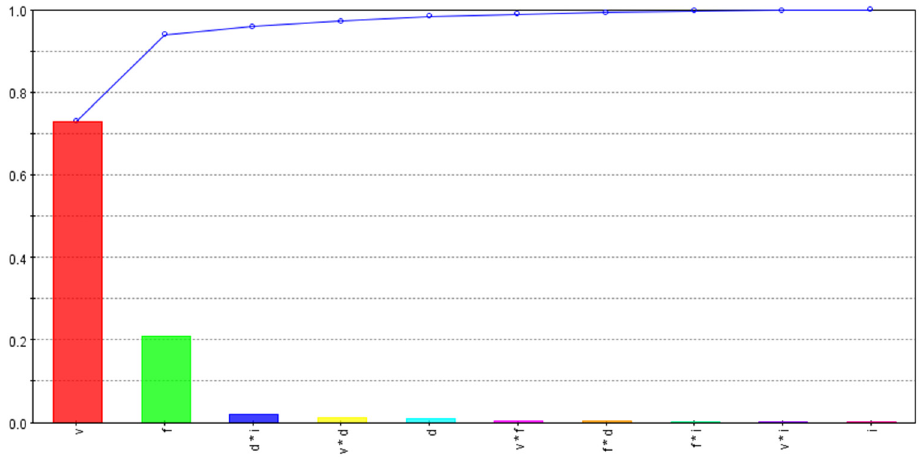
Figure 8. Tool-temperature dependencies on input variables and their interactions.